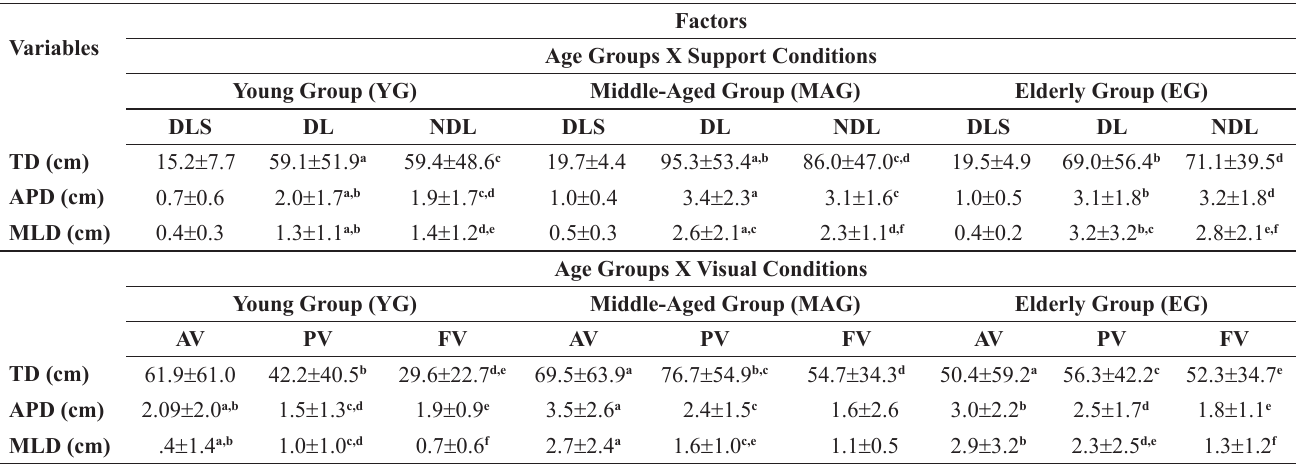
Table 1. Displacement of the center of pressure (CoP) in the interactions between factors: age groups X support conditions and age groups X visual